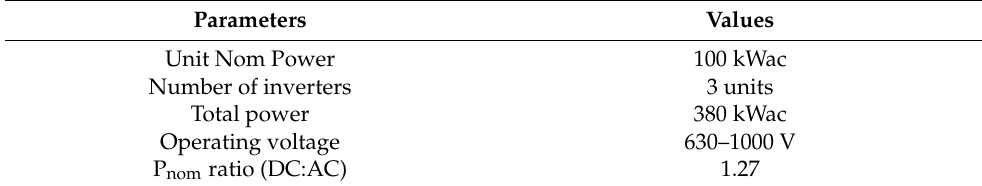
Table 6. Installed inverter